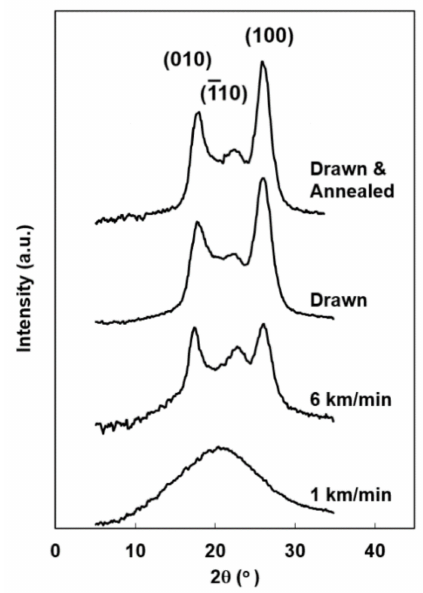
Figure 6. Equatorial WAXD intensity profiles for the high-speed spun H-PEF fibers obtained at take-up velocities of 1.0 and 6.0 km/min. Intensity profiles of drawn fiber and drawn and annealed fiber are also shown for